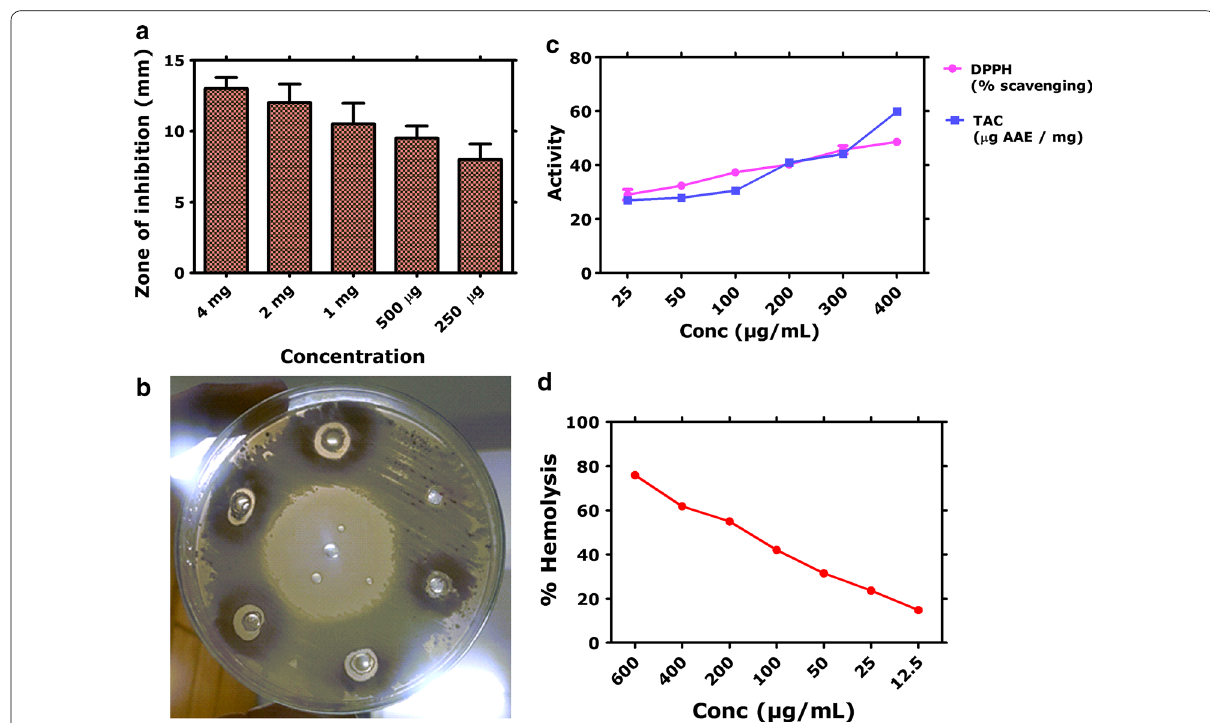
Fig. 7 PK, antioxidant and hemolytic potential. a , b Protein kinase inhibition; c Antioxidant potential; d Hemolytic potential